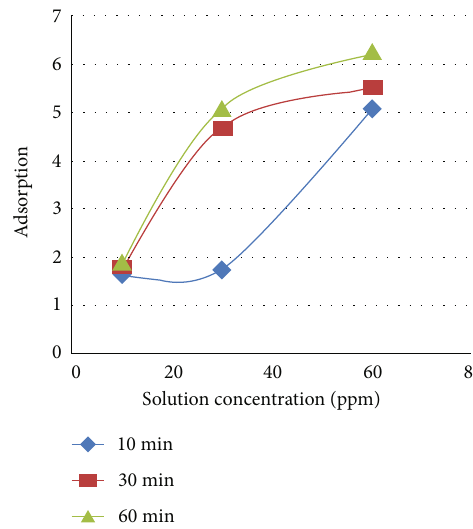
Figure 5: The relationship of the adsorption concentrations of solutions for di ff erent times at the pH 4.